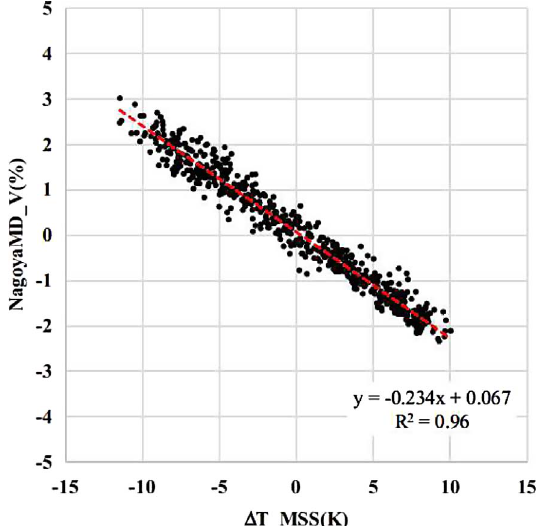
Fig. 11. A scatter plot between D T MSS and the pressure corrected daily mean count rate in Nagoya MD vertical channel